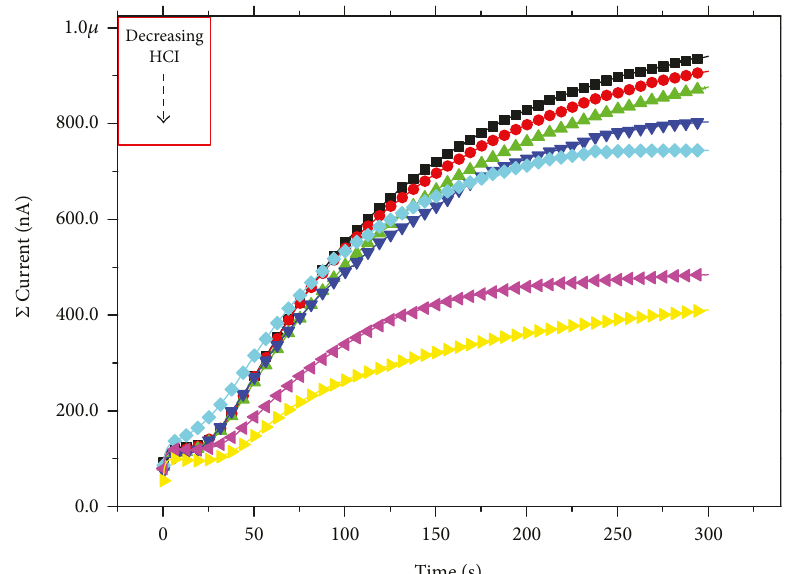
Figure 6: Memristor system ’ s responses to the voltage stimulus reported in the inset of Figure 1 in which one device undergoes a performance degeneration inducted by a progressive lowering of chloride ion content in the polyelectrolyte: black squares represent the curve obtained in the 1 ° iteration; red circles 2 ° iteration; green triangles 3 ° iteration; blues triangles 4 ° iteration; light-blue squares 5 ° iteration; magenta triangles 6 ° iteration; and yellow triangles 7 ° iteration.